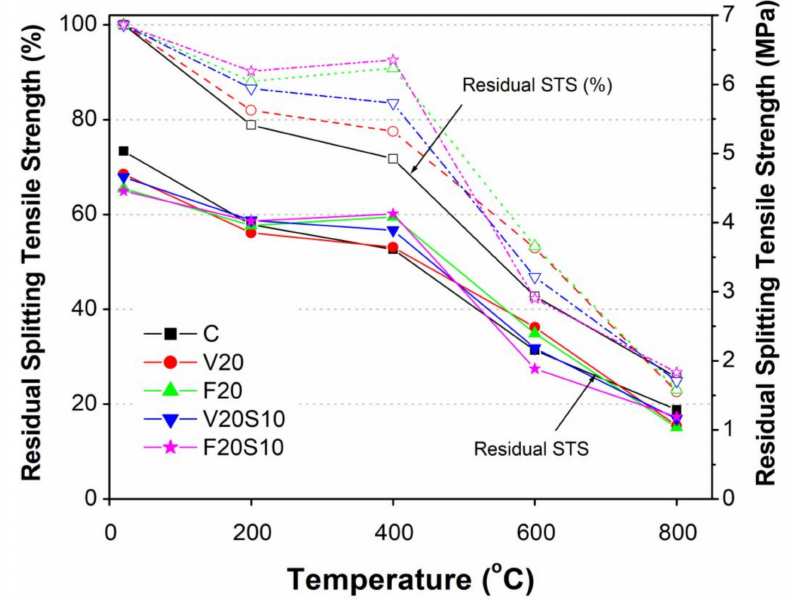
Figure 8. Comparison of residual splitting tensile strength of VA concretes with that of CC and reference FA